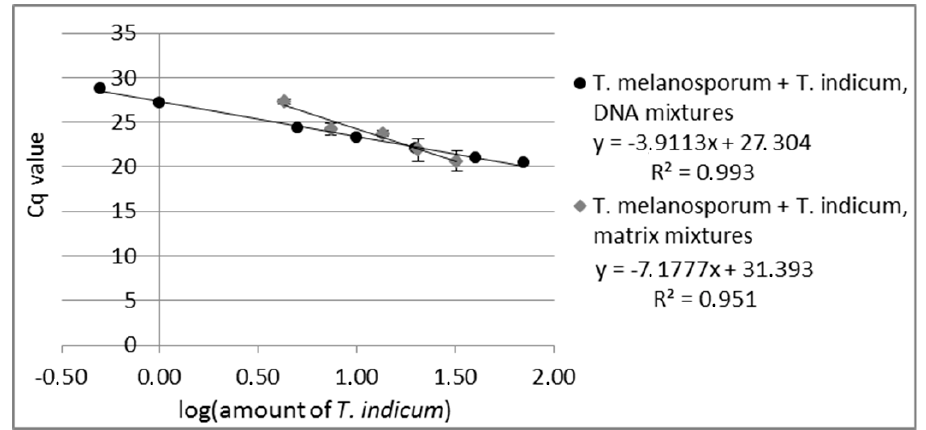
Figure 1. Standard curve of real-time PCR of DNA-mixtures from T. melanosporum with T. indicum with 0.5%, 1%, 5%, 10%, 20%, 40%, 70% T. indicum DNA and standard curve of matrix-mixtures from T. melanosporum with T. indicum with 4.3%, 7.4%, 13.5%, 20.4, 32.2% T. indicum . Each DNA-mixture was analyzed in duplicate and each matrix mixture in triplicate to real-time PCR with the primer pair specific to T. indicum . The Cq values are plotted against the logarithm of T. indicum amount.